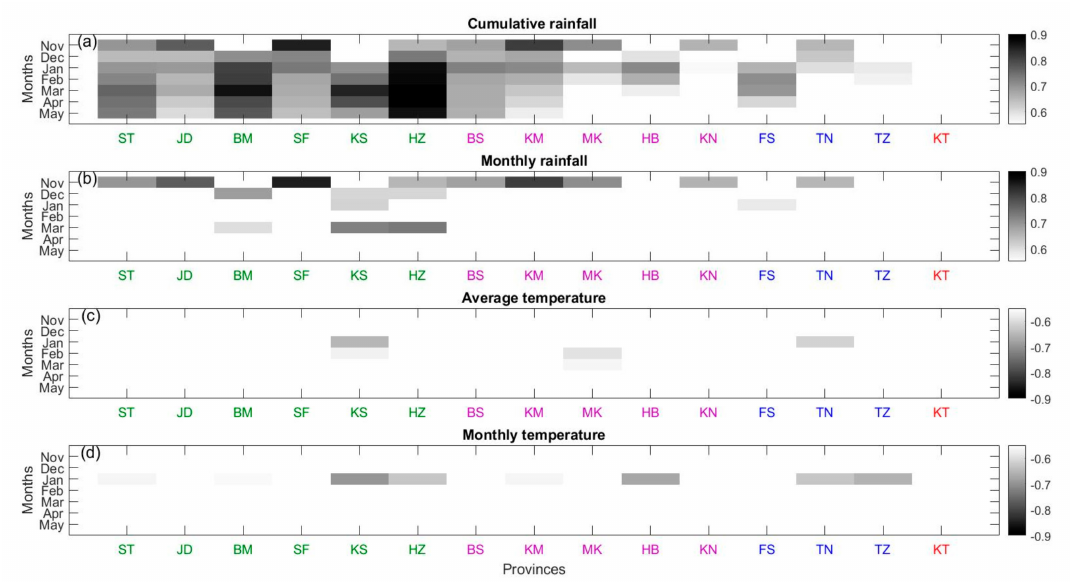
Figure A3. Correlation between the cumulative rainfall ( a ), monthly rainfall ( b ), average temperature ( c ), monthly temperature ( d ) and cereal yields on the province scale. ST: Settat, JD: El Jadida, BM: Beni Mellal, SF: Safi, KS: Kelaa des Sraghna, HZ: Haouz, BS: Ben Slimane, KM: Khemisset, MK: Meknes, HB: El Hajeb, KN: Khenifra, FS: Fes, TN: Taounat, TZ: Taza, KT: Kenitra. All the correlations are significant at the 99% level.